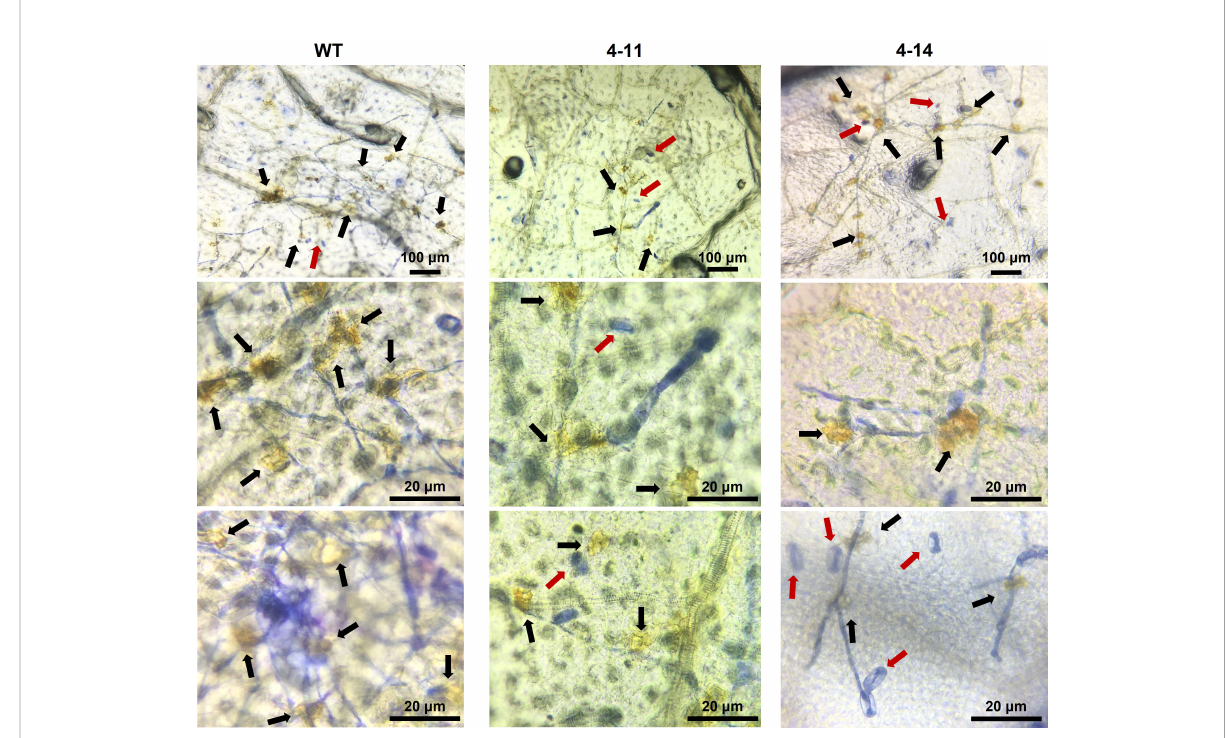
FIGURE 6 Combined DAB and Trypan blue staining to determine ROS accumulation on leaves of inoculated WT and mutant plants at 10 dpi. Although susceptible WT-ADR27 had highest P. xanthi germination rate, ROS accumulation (black arrow) was found more frequently on the leaves of these plant as compared 4-11 and 4-14. ROS accumulation was also found in 4-11 and 4-14 which are CsaMLO8 /11 del and CsaMLO1 A137N /8/ 11 del mutants. However, ROS were accumulated in the P. xanthii mycelial growth site was detected in 4-11 and 4-14. Also, non-germinated spores (red arrow) were detected on mutant leaves on the contrary to